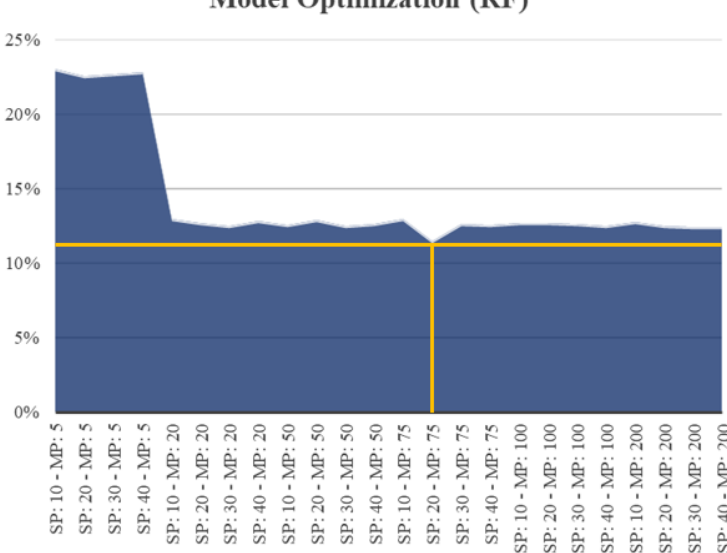
Figure 17. RF model optimization for total PV (with spatial variables).